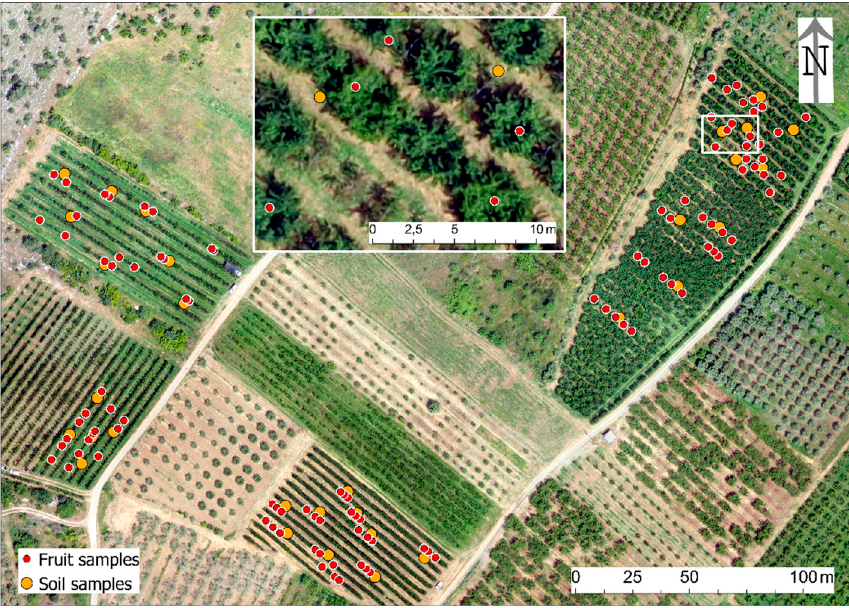
Figure 2. The fruit and soil samples in Sevastiana (a close view in the inset). Antioxidants 2020 , 9 , x FOR PEER REVIEW